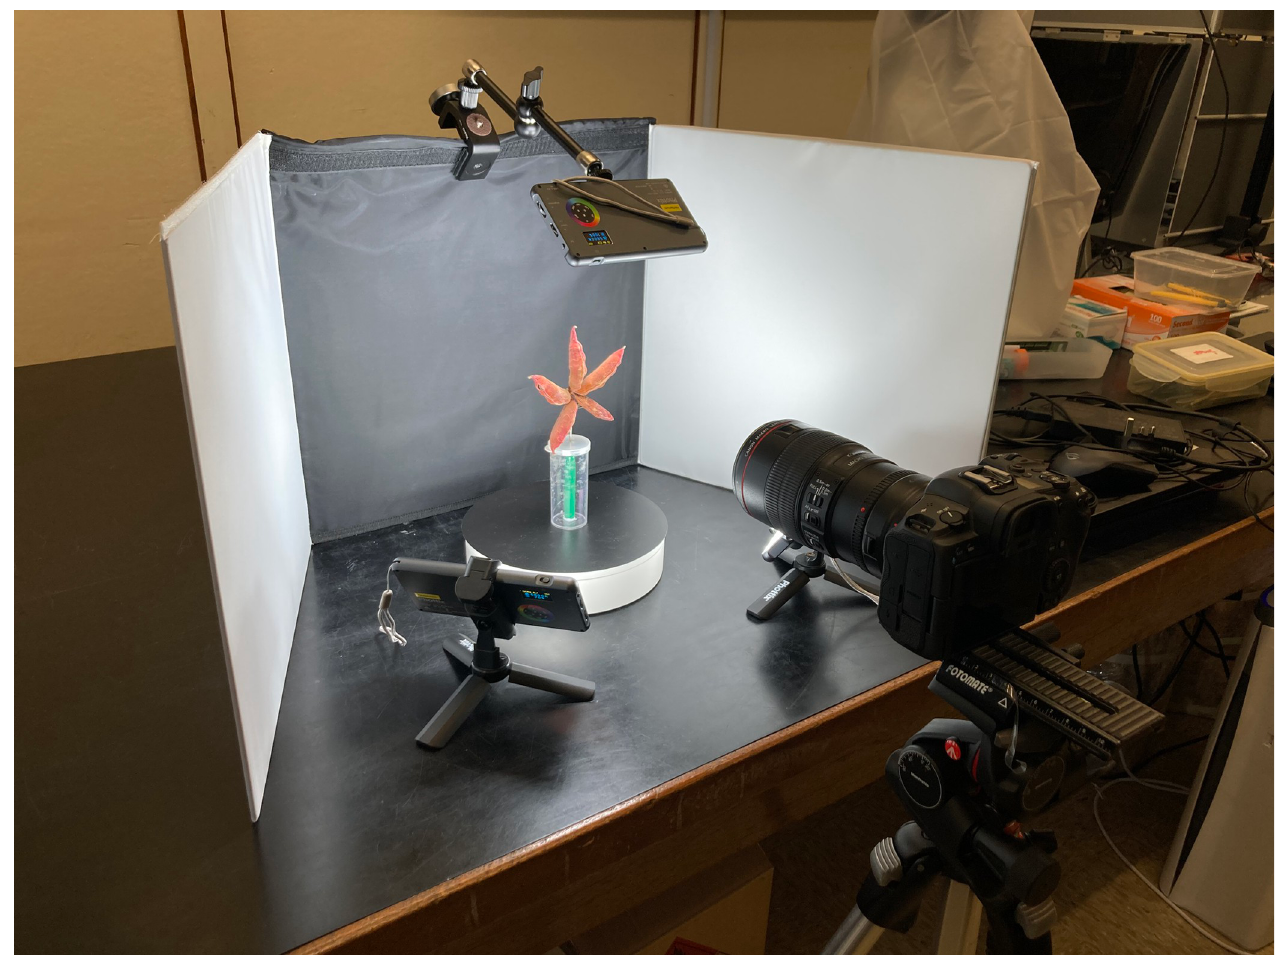
Fig 1. Set up of the photogrammetric station. A mirrorless camera Canon EOS R5 with a macro lens (Canon EF 100mm f/2.8L Macro IS USM) is mounted on a tripod. The carpological material is affixed on a pin which is placed in the middle of a turntable. Three light-plates are placed on the top, left and right side of the carpological material. A portable photo studio is used as